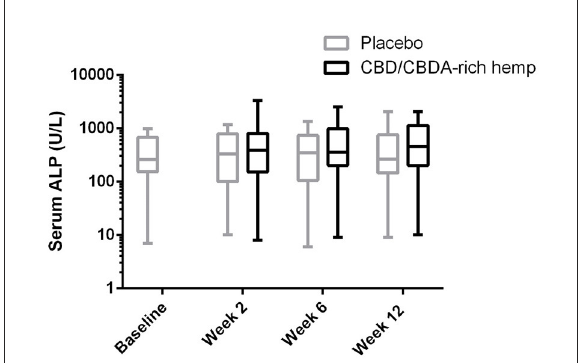
FIGURE1 Log serum ALP activity shown over 12 weeks in both CBD/CBDA-rich hemp oil and placebo treatment phases of the study. No differences were observed across time or between groups at any time point, however there is a global treatment effect with slightly elevated ALP concentrations ( P <